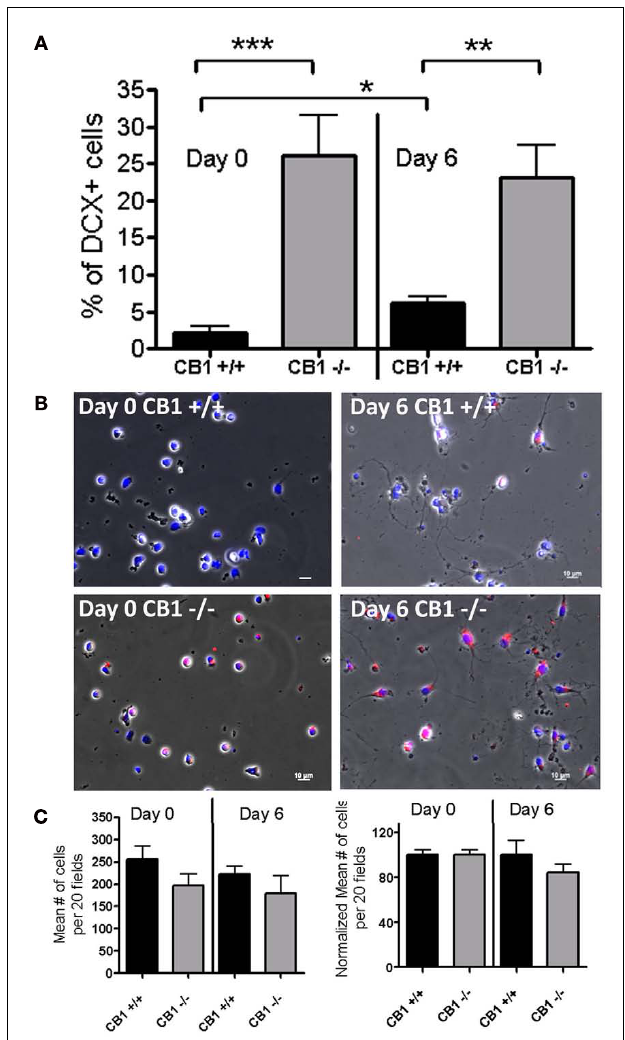
FIGURE 5 | Comparison of percentages of DCX( + ) cells at Day 0 and Day 6 between CB1 + / + and CB1 − / − spinal cord cultures. (A) Percentage of DCX( + ) cells in mixed cultures derived from CB1 + / + (wild type, Black bars) and CB1 − / − (CB1R knock-out, Gray bars) animals.Twenty fields per coverslip; n = 9 coverslips from three mice per genotype. Significant differences between CB1 + / + and CB1 − / − groups are evident at both time points. Under basal growth conditions, there was a modest increase in the percentage of DCX( + ) cells in CB1 + / + cultures from Day 0 to Day 6, whereas in CB1 − / − cultures the high percentages of DCX( + ) cells remained unchanged during the same period. * p < 0.003, ** p < 0.0003, *** p < 0.0004 (Unpaired t -test, two tailed).Twenty fields were analyzed per coverslip ( n = 9 coverslips, from three different animals; mean + SEM). (B) Typical morphology of spinal cord cells at Day 0 (left panels), 2h after plating-small rounded somata, with occasional extensions, and of spinal cord cells at Day 6 (right panels) with growth media. Nuclei (blue); immunostained with anti-DCX (red) and the nuclei stained with Hoechst 3392. At Day 0, a field of CB1 + / + cultures showing no DCX( + ) cells (top left panel) while a field in CB1 − / − cultures showing many DCX( + ) cells (bottom left panel). At Day 6, a field of CB1 + / + cultures showing a few DCX( + ) (top right panel) and a field in CB1 − / − cultures showing a large number of DCX( + ) (bottom left panel). All images are merges of Hoechst/DCX/DIC light picture, and were corrected for